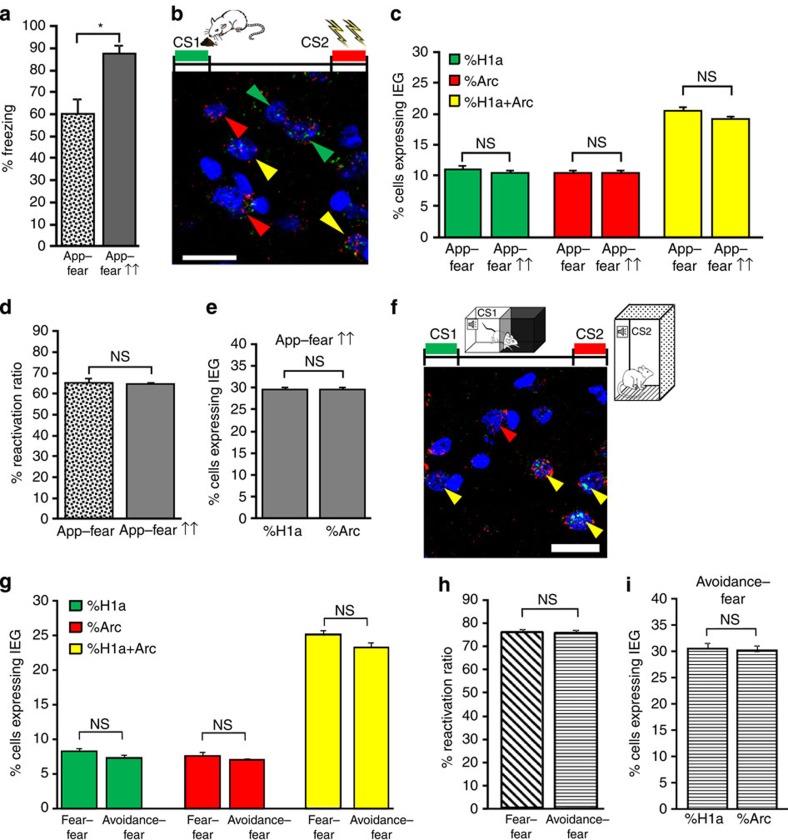
Te2 neurons encode the memory valence but not the salience nor the different behavioural response.(a) A more intense aversive memory was obtained by increasing the strength of aversive conditioning (app–fear↑↑, n=4). Freezing response was higher in this appetitive–fear group than in the previous appetitive–fear experiment (t10= −2.56, P<0.05). (b) Representative fluorescent photomicrograph of cortical neurons in animals conditioned to stronger foot shock stimuli. Scale bar, 20 μm. CS1 and CS2, conditioned stimuli 1 and 2. (c) The percentages of cells expressing only H1a (t10=−0.58, NS), only Arc (t10= 0.15, NS) or both H1a and Arc (t10=−1.43, NS) were similar between stronger (app–fear↑↑) and weaker (app–fear) fear-conditioned animals. (d) Similarly, there were no significant differences between groups in the reactivation ratio (t10=−0.15, NS). (e) In the animals conditioned with stronger painful stimuli, the percentage of H1a-positive cells was similar to that of Arc-positive cells (t6=−0.01, NS). (f) Representative fluorescent photomicrograph showing H1a (green arrows), Arc (red arrows) or doubly (yellow arrows) labelled neurons in the avoidance-fear group (n=5). Scale bar, 20 μm. (g) The percentages of neurons expressing H1a (t12=−1.16, NS), Arc (t12=−0.6, NS) or both (t12=−1.87, NS) were similar in the avoidance-fear and fear–fear groups. (h) No significant differences between groups in the reactivation ratio were noted (t12=0.48, NS). (i) In the avoidance–fear group, the percentage of H1a-positive cells was similar to that of Arc-positive cells (t8=−0.24, NS). * P<0.05; NS, not significant. All values are mean and s.e.m.